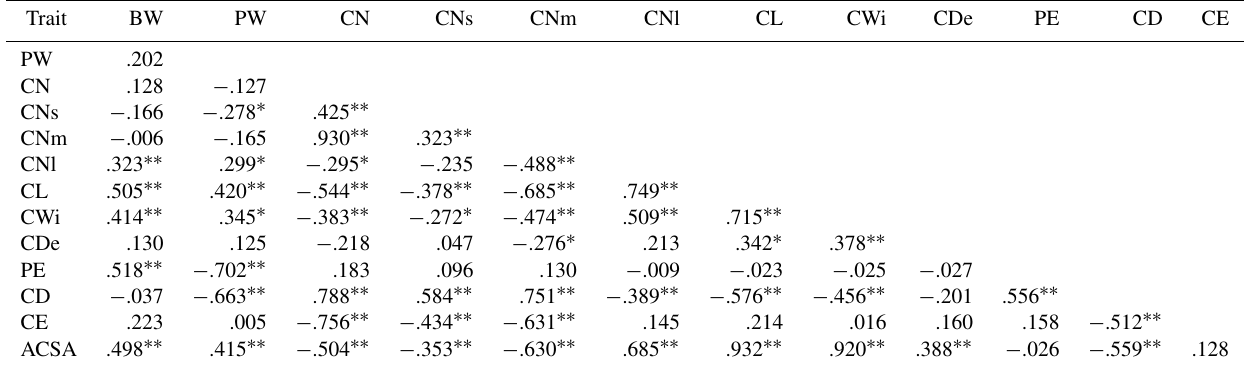
Table 3. Pearson correlation coefficient of placental and cotyledon traits. Trait BW PW CN CNs CNm CNl CL CDe PE CD CE PW .202 CN